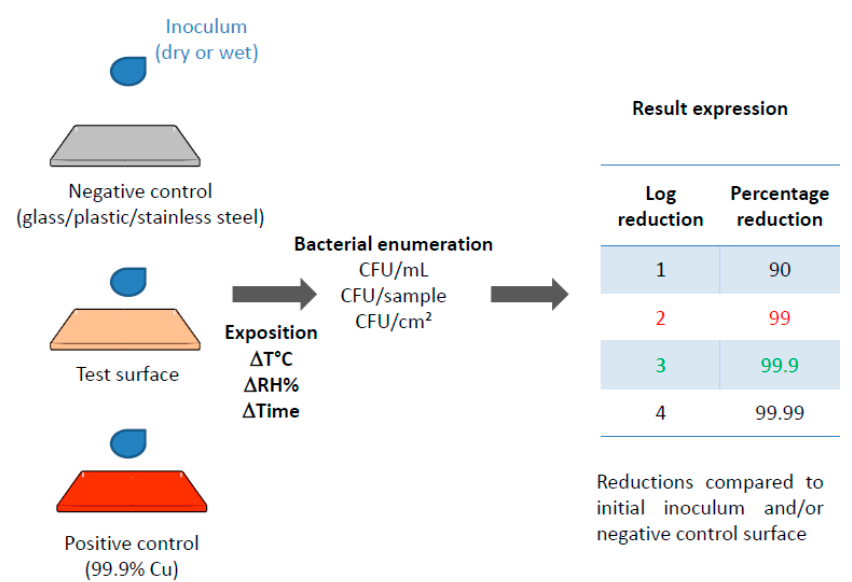
Figure 2. Antibacterial efficacy of copper-containing surfaces: general procedure and calculations. Reduction cutoff values compared to stainless steel for the validation of an anti-microbial efficacy according to Association Française de NORmalisation (AFNOR) NFS90-700 (in red) and US Environmental Protection Agency (EPA) (in green).